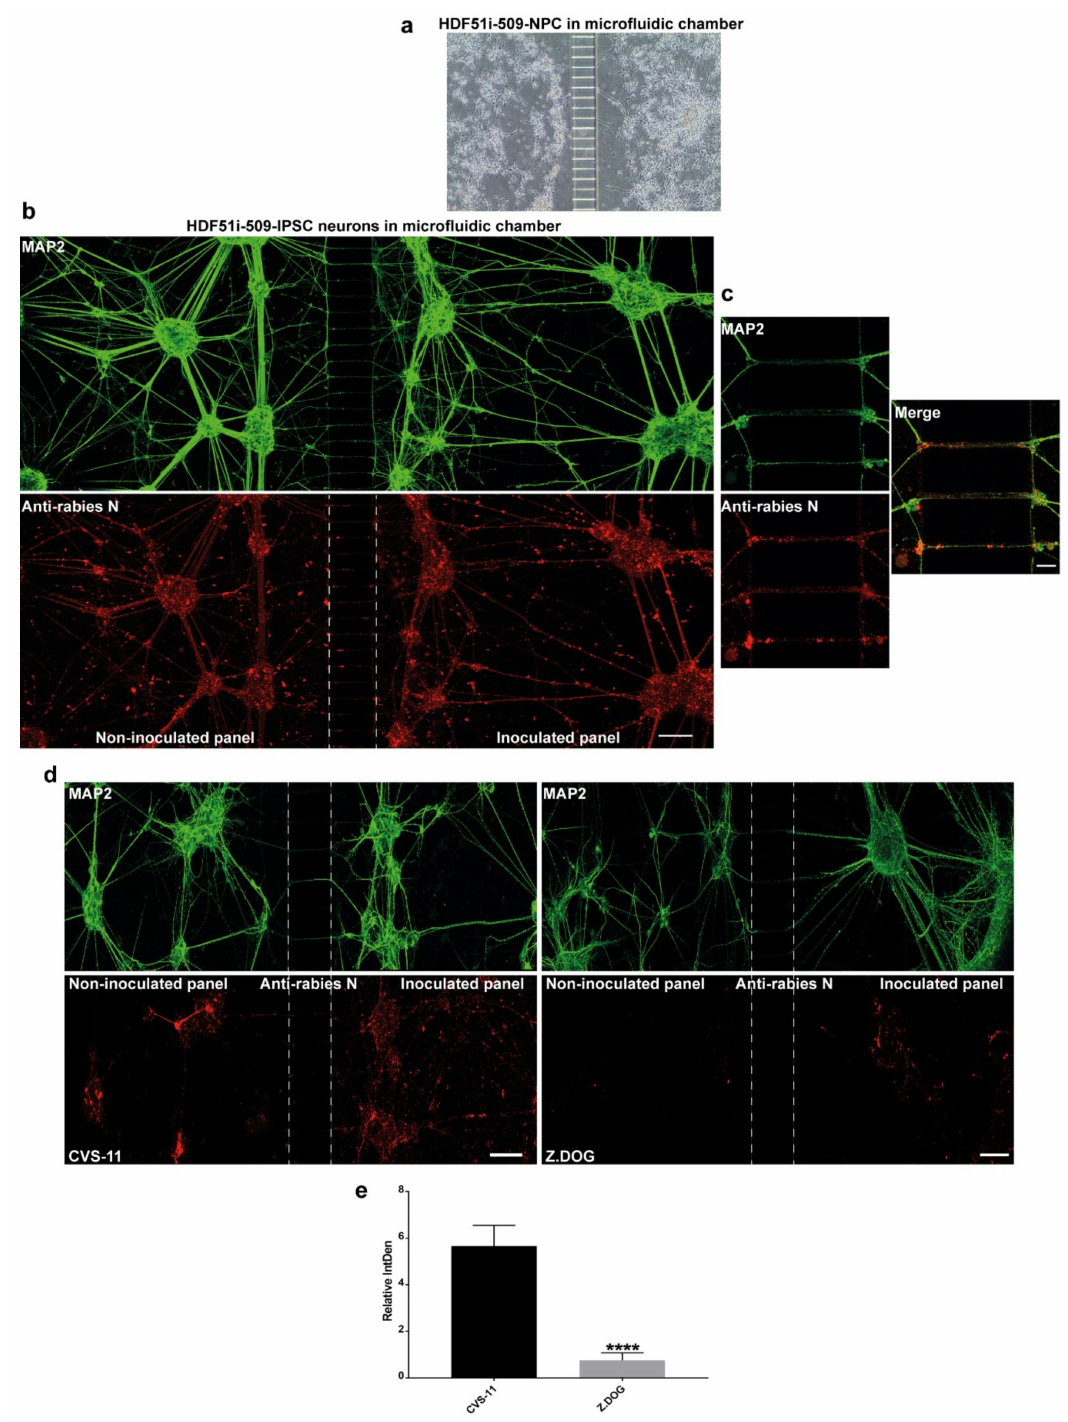
Figure 5. Stem cell-derived ex-vivo model of human neuronal network. ( a ) Representative DIC image taken using 10 × objective of Xona microfluidic device seeded with HDF51i-509-NPCs at 5 days post-di ff erentiation. ( b ) HDF51i-509-NPCs after 26 days of di ff erentiation in microfluidic device were infected with CVS-11 rabies virus in the inoculated panel for 72 h. A unidirectional flow of media from the non-inoculated panel to the inoculated panel is maintained to prevent random di ff usion of viral particles. Immunostaining with MAP2 (green) reveals extensive neuronal network between the panels after 26 days of di ff erentiation. Immunostaining with rabies nucleoprotein antibody (red) shows equivalent viral antigen between both panels, indicating e ffi cient spread of CVS-11 rabies infection within and between the neuronal networks of both panels. Confocal images were taken